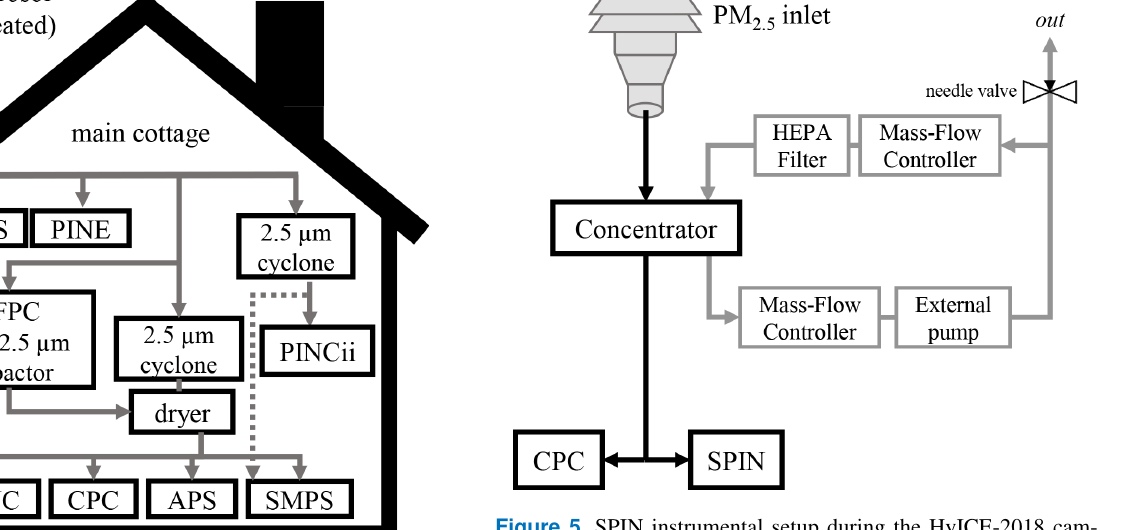
Figure 5. SPIN instrumental setup during the HyICE-2018 cam-